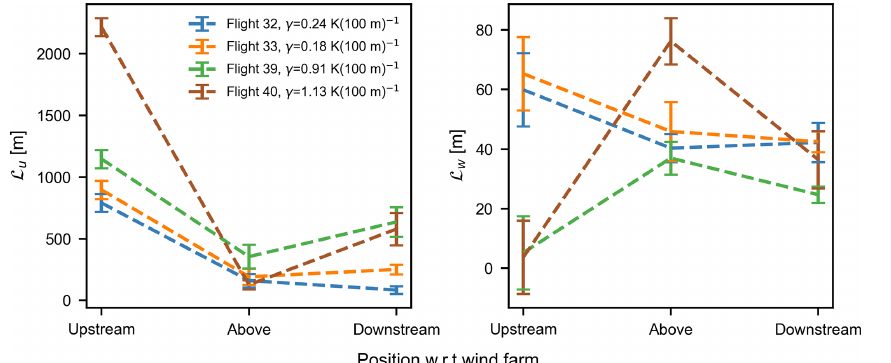
Figure 6. Longitudinal length scales L u and vertical length scales L w at different positions relative to the wind farm plotted for all the four flights. Error bars represent the standard error of the mean